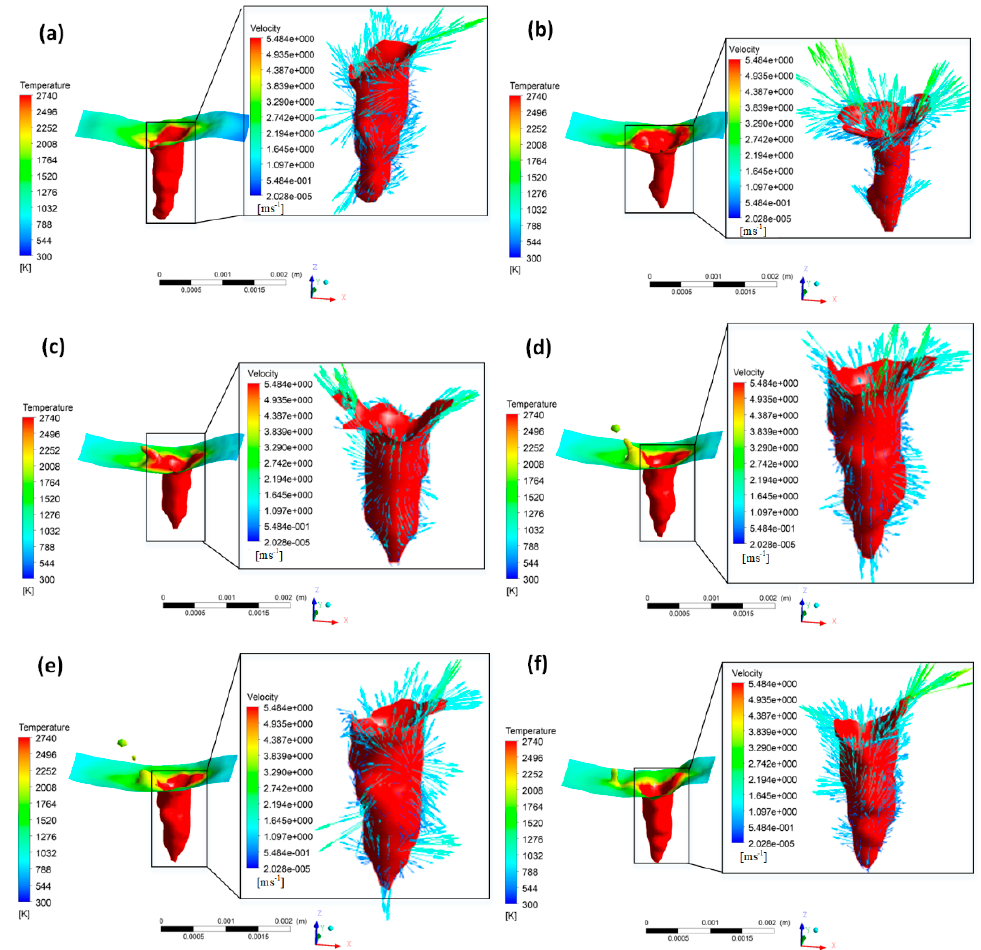
Figure 4. Three-dimensional transient behavior of the keyhole when the welding speed was 6 m/min: ( a ) t = 17 ms, ( b ) t = 18.1 ms, ( c ) t = 18.2 ms, ( d ) t = 18.3 ms, ( e ) t = 18.4 ms, ( f ) t = 18.5 ms.